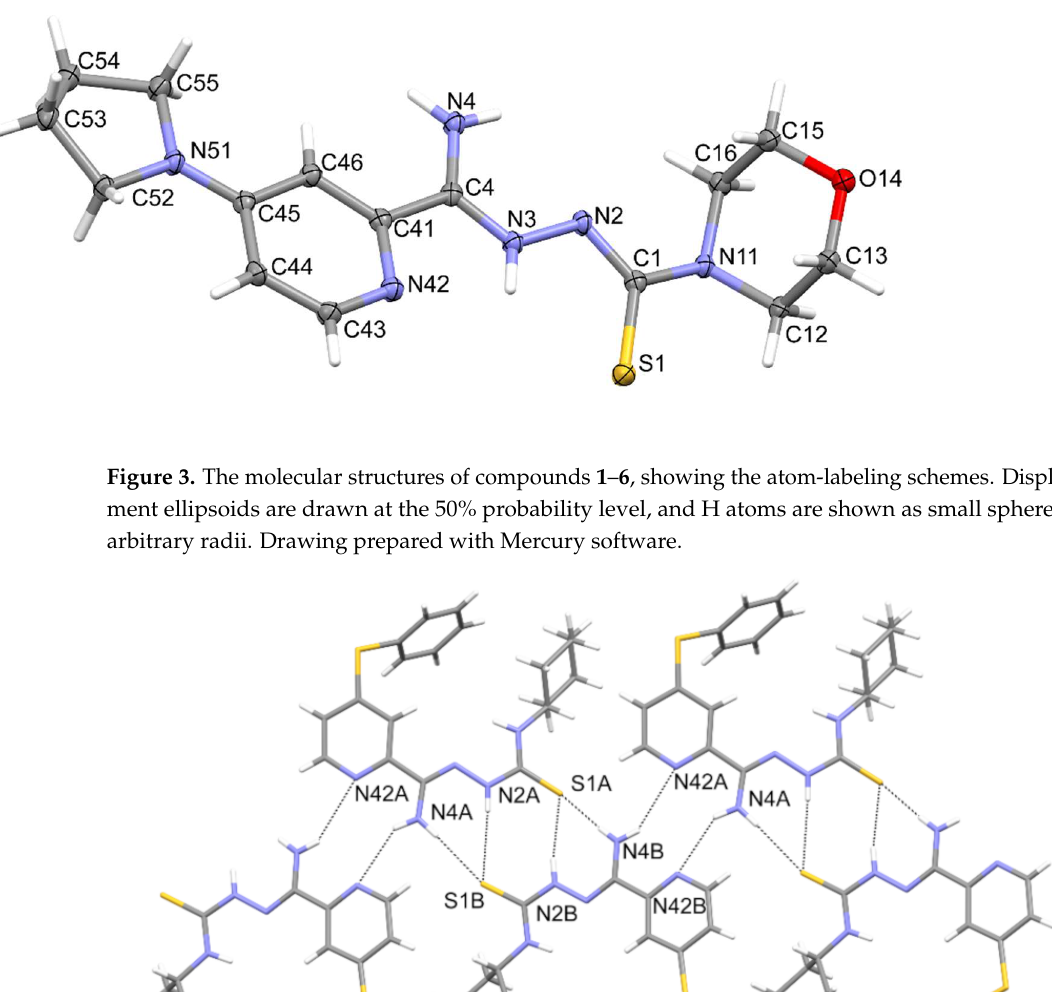
Table 3. Hydrogen-bond geometry (Å, °) for compound 1 .